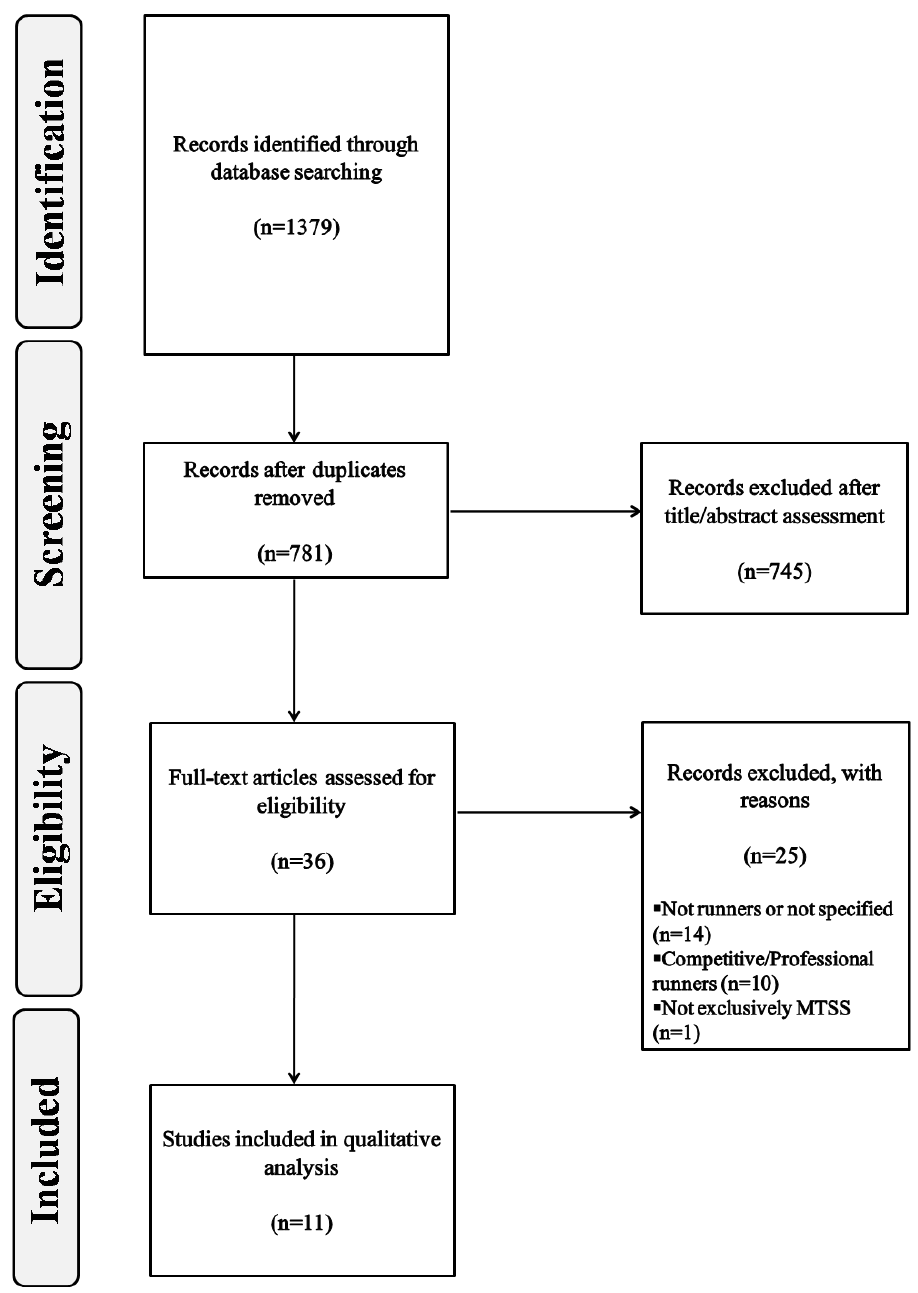
Figure 1. Flow diagram of study selection process. MTSS: medial tibial stress syndrome